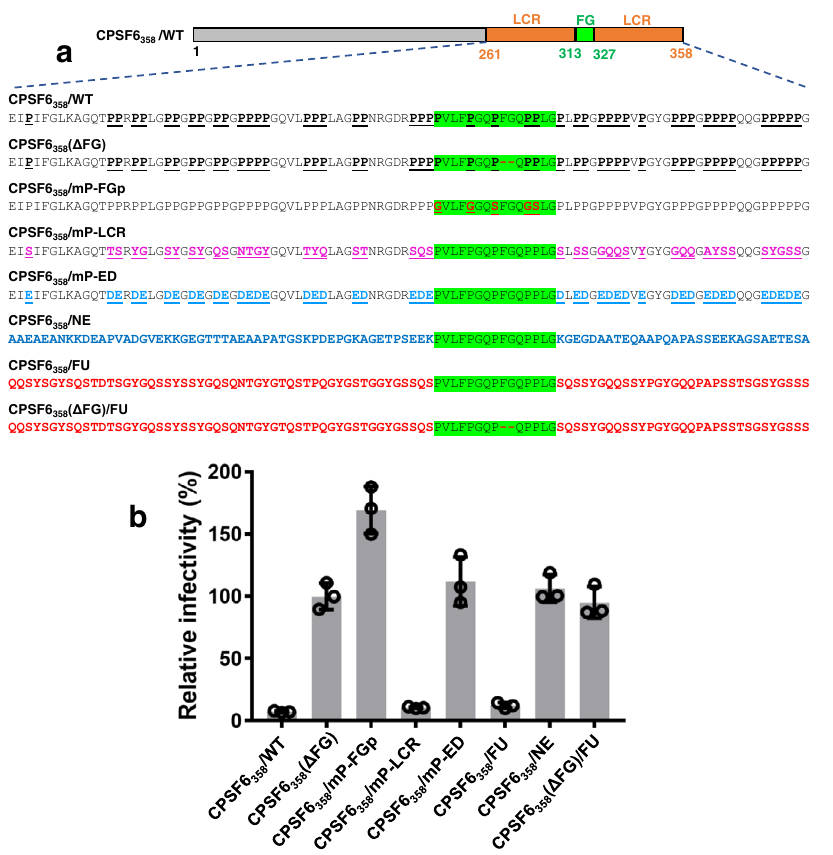
Fig. 7 | HIV-1 infectivity assays probing a role of Pro residues in the context of CPSF6(LCR-FG-LCR).a SchematicofWTandmutantCPSF6 1-358 constructs.Amino acid sequences of the CPSF6(LCR-FG-LCR) segment targeted by mutagenesis are shown. CPSF6 358 /WT: native Pro residues are in bold and underlined. The FG con- taining peptide is highlighted in green. CPSF6 358 ( Δ FG): FG residues were deleted. CPSF6 358 /mP-FGp:ProresiduesintheFG-containingpeptideweresubstitutedwith Gly or Ser. CPSF6 358 /mP-LCR: Pro residues in the LCR segments were substituted with non-charged residues. CPSF6 358 /mP-ED: Pro residues in the LCR segments